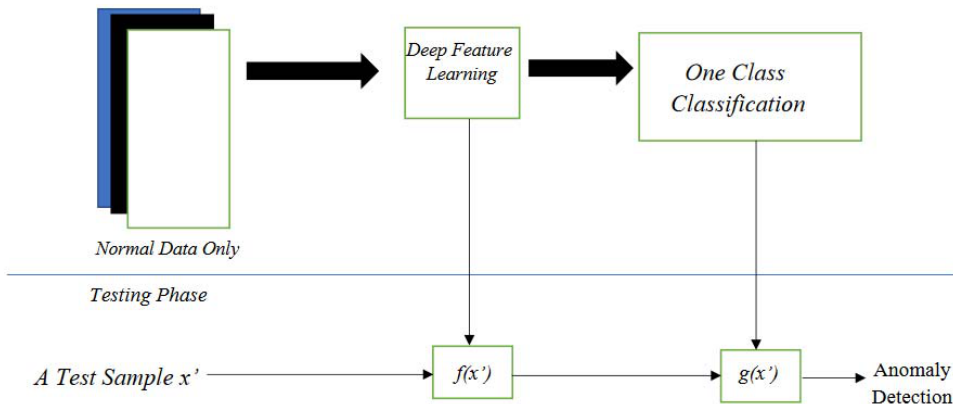
Figure 12. The overall system architecture.